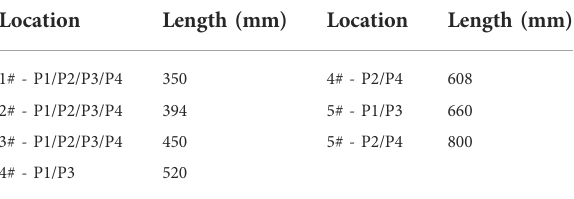
Figure 7 indicates the acceleration time history and the Fourier spectrum of the measured point near container 5# (section ΙΙ ’ ) when the soil was saturated under 0.15 g El Centro earthquake excitation.